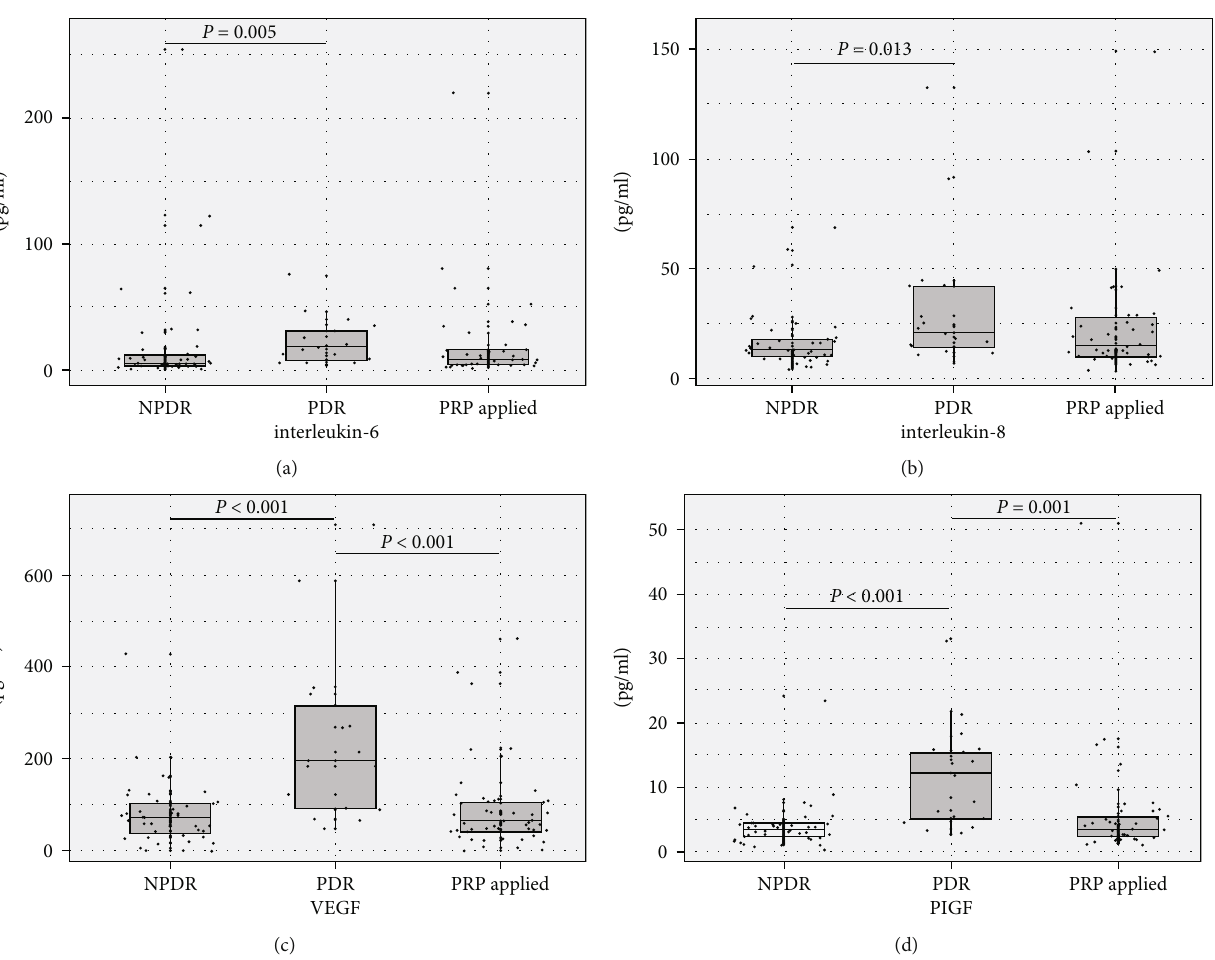
Figure 1: Box-and-jitter plots of the aqueous levels of IL-6 (a), IL-8 (b), VEGF (c), and PlGF (d) in NPDR, PDR, and post-PRP patients. The IL-6, IL-8, VEGF, and PlGF levels of PDR patients were signi fi cantly higher than those of NPDR patients. The VEGF and PlGF levels in the PDR group were higher than those in the post-PRP group. IL: interleukin; VEGF: vascular endothelial growth factor; PlGF: placental growth factor; NPDR: nonproliferative diabetic retinopathy; PDR: proliferative diabetic retinopathy; PRP: panretinal